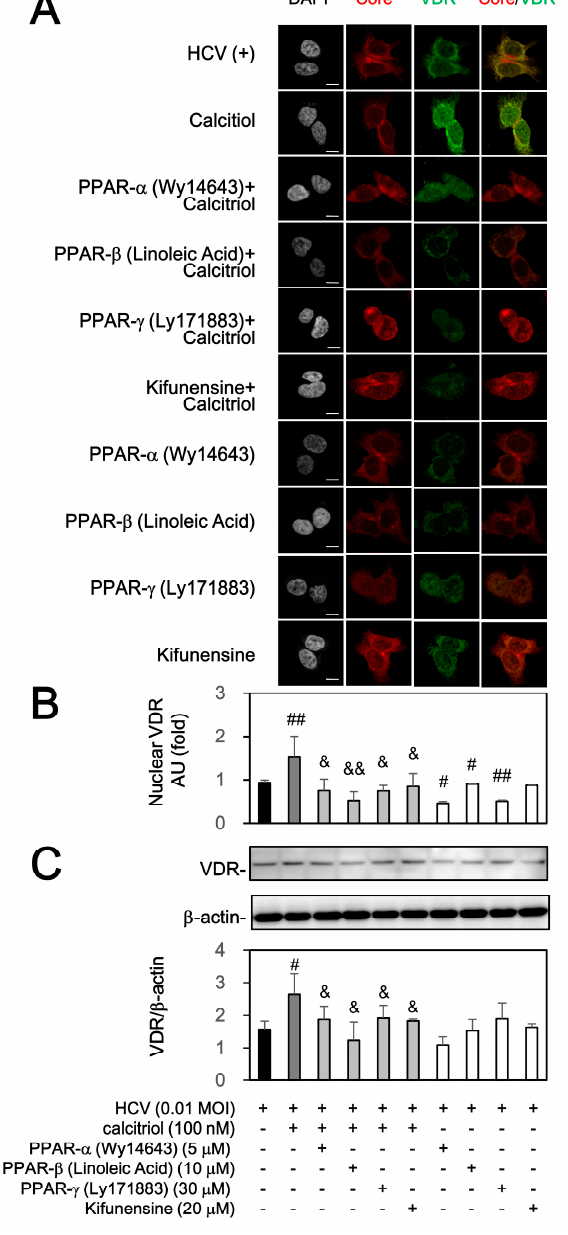
Figure 5. Effects of calcitriol, PPAR stimulators and ERAD inhibitor on expression of VDR. ( A ) HCV-infected Huh7.5-SEAP cells (1.5 × 10 4 ) were treated with 5 µ M of Wy14643, 10 µ M of linoleic acid, 30 µ M of Ly171883, or 20 µ M of kifunensine for 1 h ahead of treatments with 100 nM of calcitriol for 6 days in a 24-well plate, fixed with 1% paraformaldehyde, stained with core and VDR antibodies and counterstained with DAPI. After staining, these cells were mounted on glass slides and observed under confocal laser scanning microscope. Scale bar, 10 µ M; ( B ) The arbitrary units (AU) of immunofluorescence intensity were assessed using Image J; ( C ) Cell lysates (7 × 10 5 ) were collected and the VDR level was detected by Western blot. Data are expressed as mean ± SD obtained from three individual experiments. # p < 0.05 and ## p < 0.01 vs. compared with the HCV-infected Huh7.5-SEAP group. & p < 0.05 and && p < 0.01 vs. the calcitriol-treated group. The symbol (–) referred to the cells without HCV infection; the symbol (+) referred to the cells with HCV infection; the symbol (++) referred to the cells with HCV infection and co-treated with drug (e.g., calcitriol, individual PPAR agonist, or ERAD inhibitor); the symbol (+++) referred to the HCV-infected cells pre-incubated with individual PPAR agonist or ERAD inhibitor before calcitriol treatment.